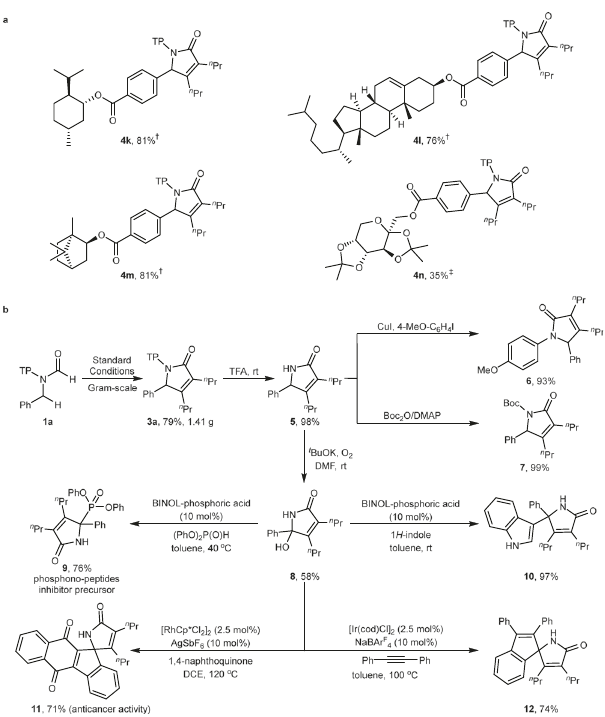
Fig. 4 | Synthetic utility. a Reaction of substrates bearing bioactive structural motifs under the optimal conditions with varying amounts of AlEt 3 . † AlEt 3 (80mol %). ‡ AlEt 3 (100mol%). b Gram-scale reaction and product transformations. TFA= tri fl uoroacetic acid. DMEDA= N,N ’ -dimethyl-1,2-ethanediamine. Boc 2 O=di( tert - butyl)carbonate. DMAP=4-dimethylamino pyridine. BINOL=( rac ) − 1,1 ’